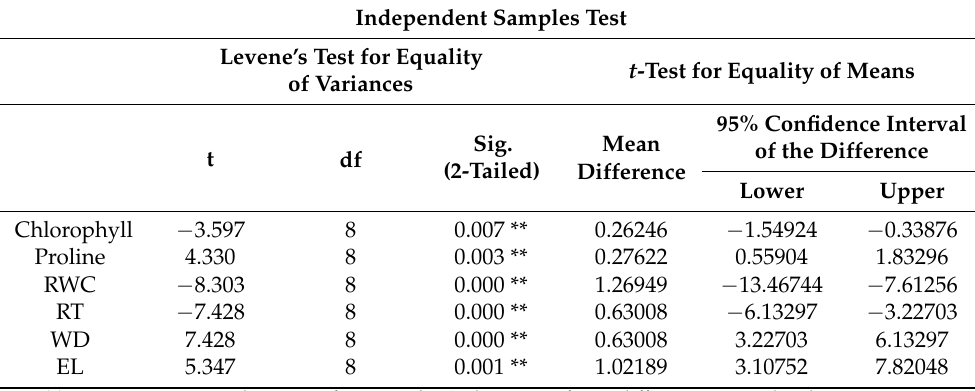
Table 3. Independent samples t -test analysis for physiological indices.